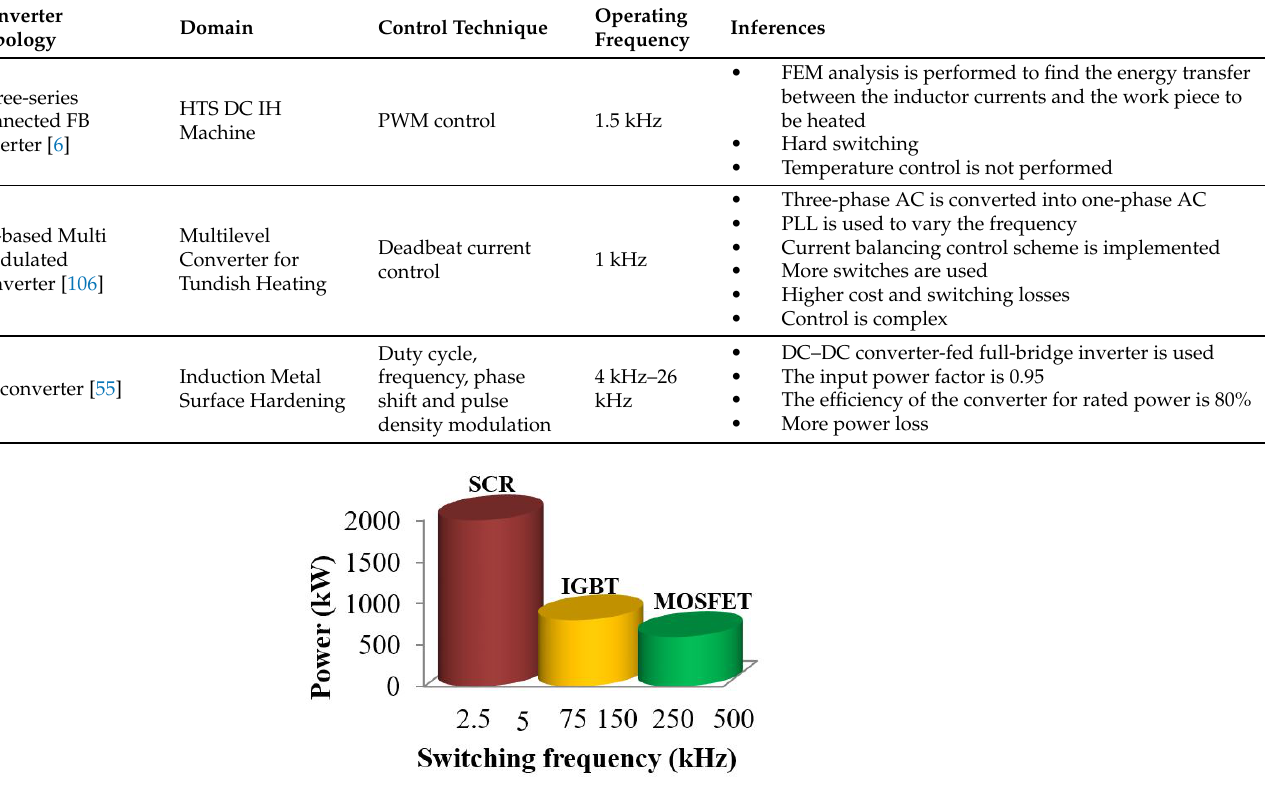
Figure 24. Rating of power semiconductor switches used in industrial heating